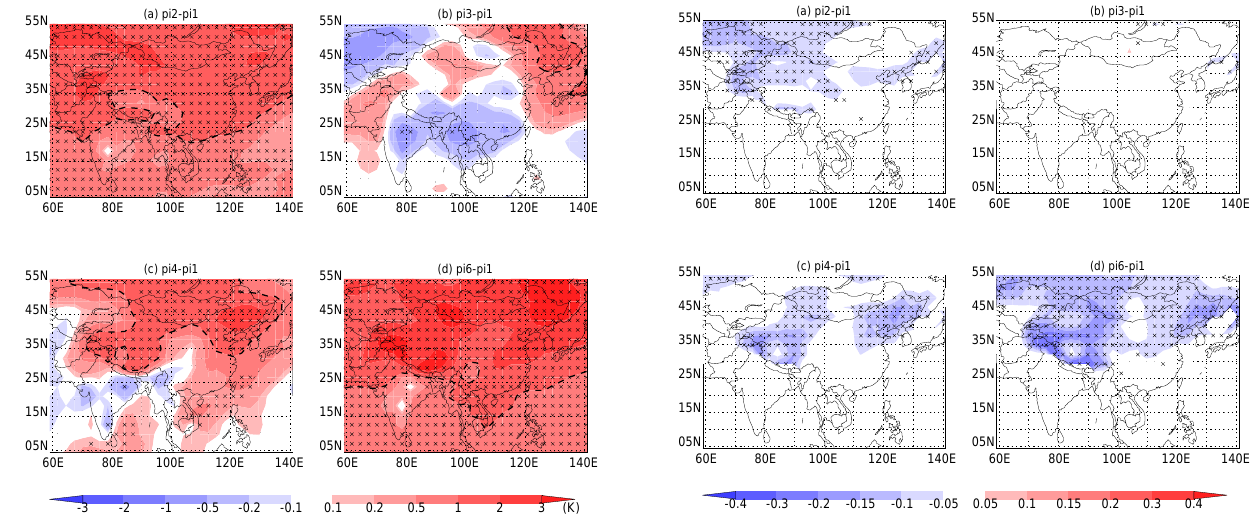
increases by around 2 ◦ over the TP, with a maximum warm- ing of 3 ◦ on April. With the addition of dust and biomass burning BC, more seasonal variation of temperature change is seen, with a maximum warming of 4 ◦ in April and cooling from April to December. The mean temperature over the TP increases by around 2.9 ◦ for January–June and increases by around 1.3 ◦ for July–December.